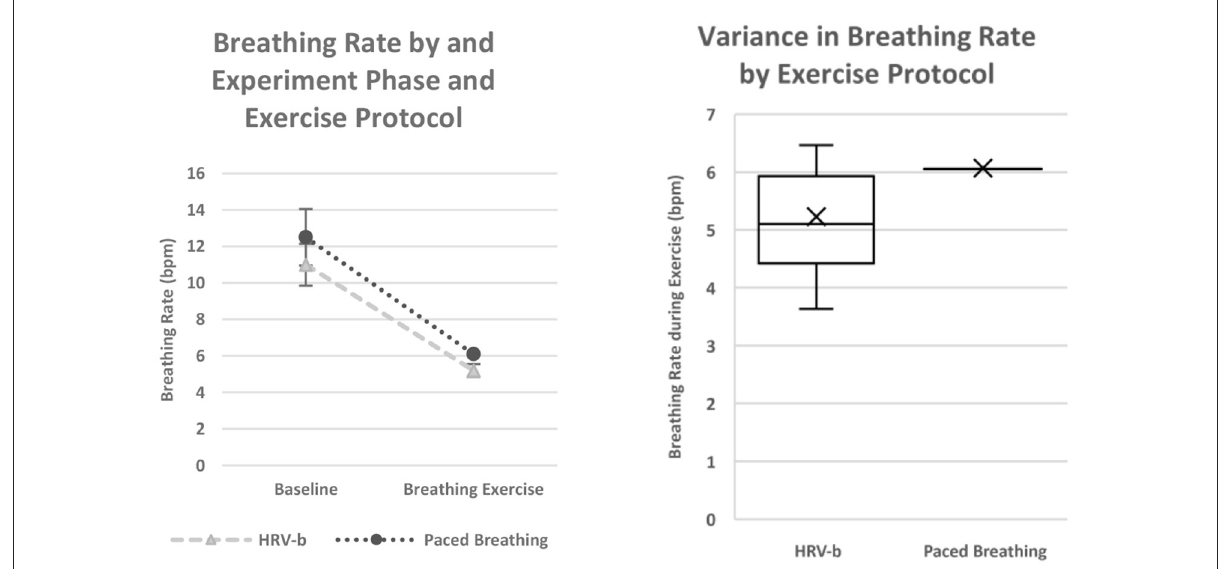
FIGURE6 Observed breathing rates during the experiment. (Left) Average breathing rates broken down by experiment phase and exercise protocol. Error bars indicate standard error of mean (SEM). (Right) Per-participant mean breathing rates while completing breathing exercises, broken down by exercise protocol . The box-and-whisker plots denote per-quartile median (i.e., “box” → 25 th , 50 th , and 75 th quartile, “whiskers” → minimum and maximum values). The “X” markers indicate per-protocol mean. A markedly larger variance in breathing rate was observed in the HRV-b group compared to Paced Breathing.